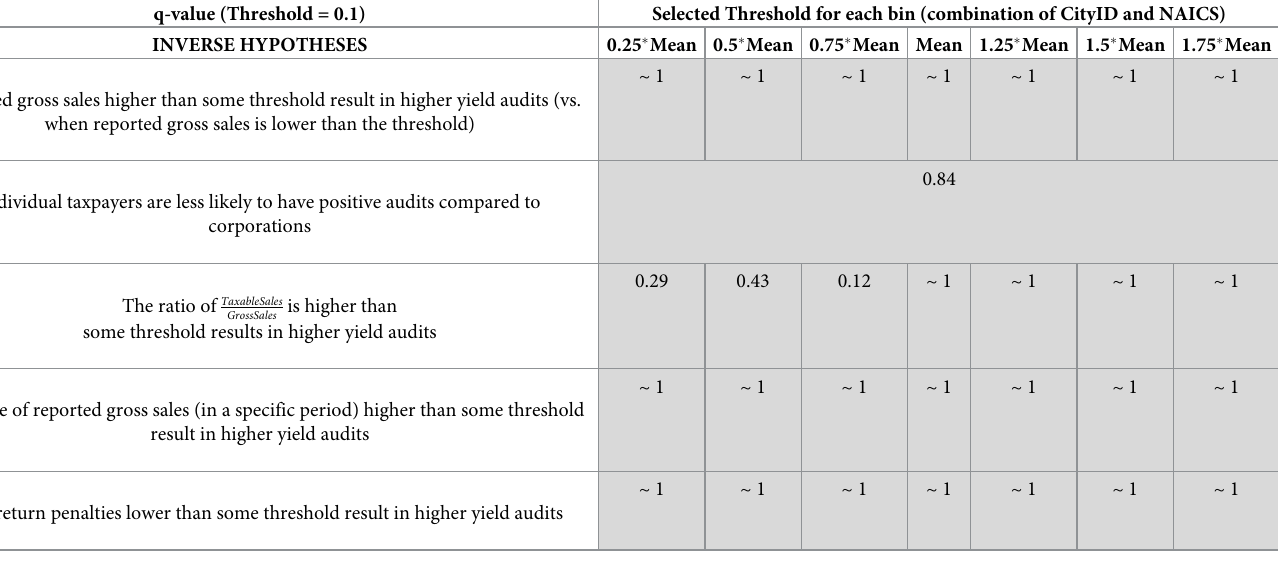
Table 2. Tax audit empirical inverse hypotheses validation. q-value (Threshold = 0.1)